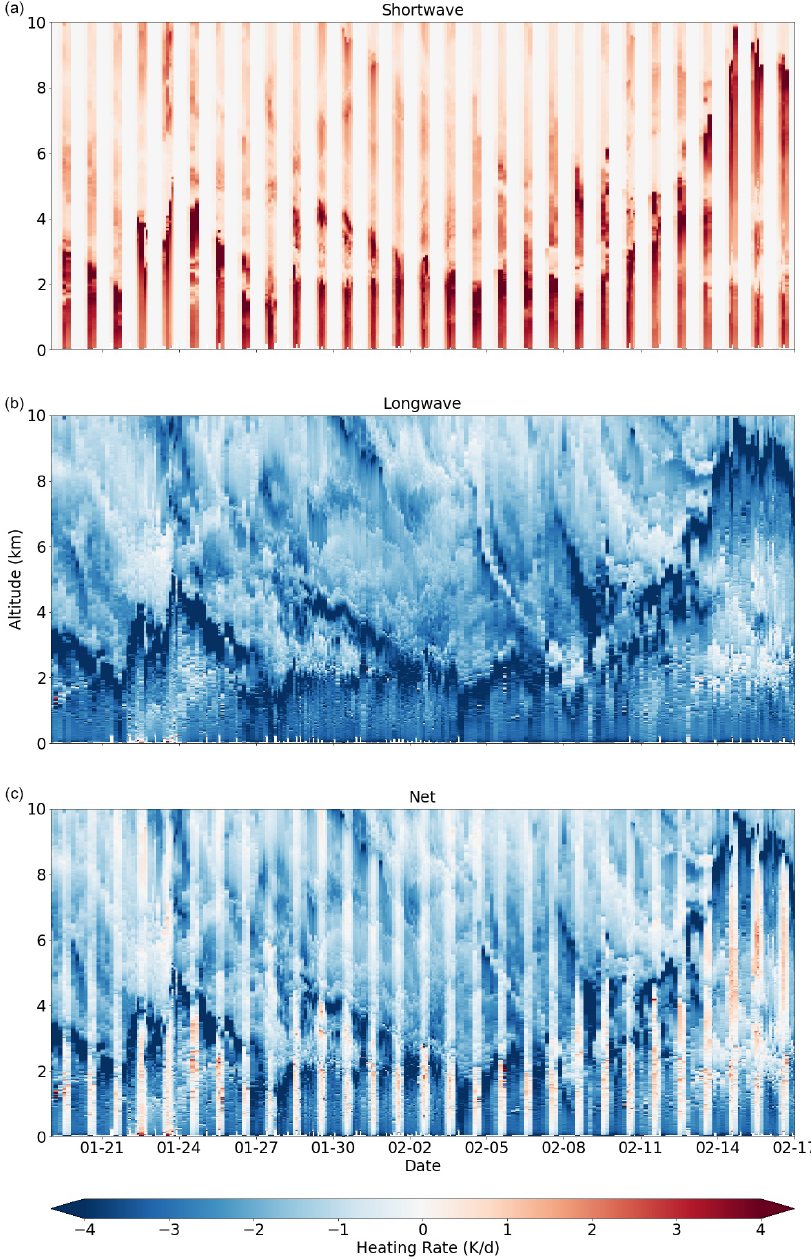
Figure 4. Shortwave (a) , longwave (b) , and net (c) heating rates at BCO during EUREC 4 A from 19 January to 17 February. The heating rates are calculated from radiosondes launched at BCO. Heating rates are in color (in units of K/day). White indicates the absence of